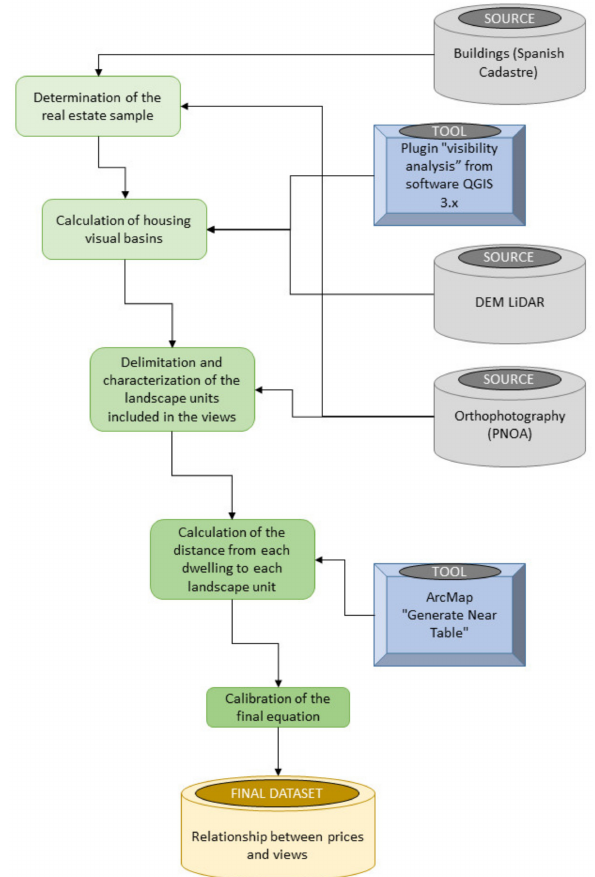
Figure 3. Explanatory flowchart of the methodological procedure.